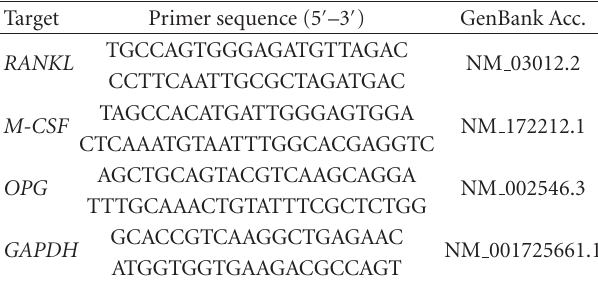
Table 1: PCR primers used in the